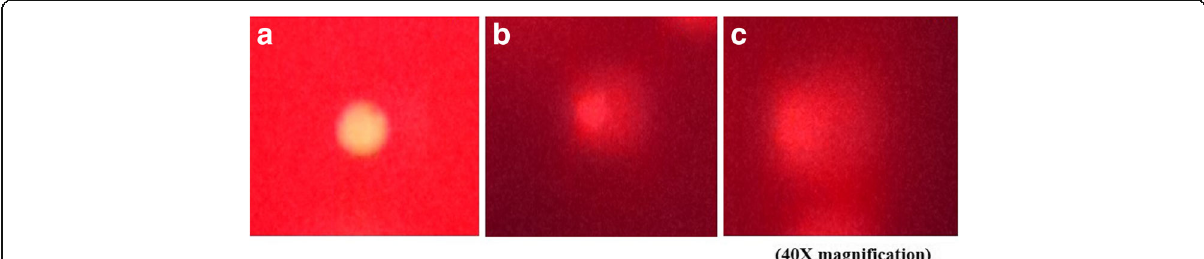
Fig. 7 Comet assay showing DNA damage in sperms of Hydroides elegans incubated in medium containing silver nanoparticles. Control untreated sperm ( a ), 3 nM ( b ), and 5 nM silver nanoparticle-treated sperm ( c